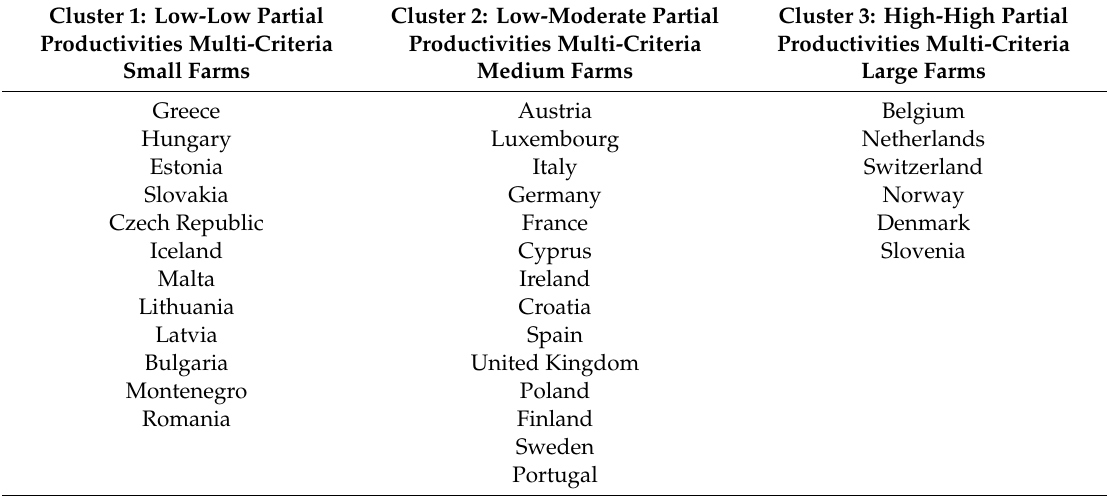
Table 3. Defining and re-naming the three clusters of European countries through the composite indicator of farm structure; Source: own calculations.